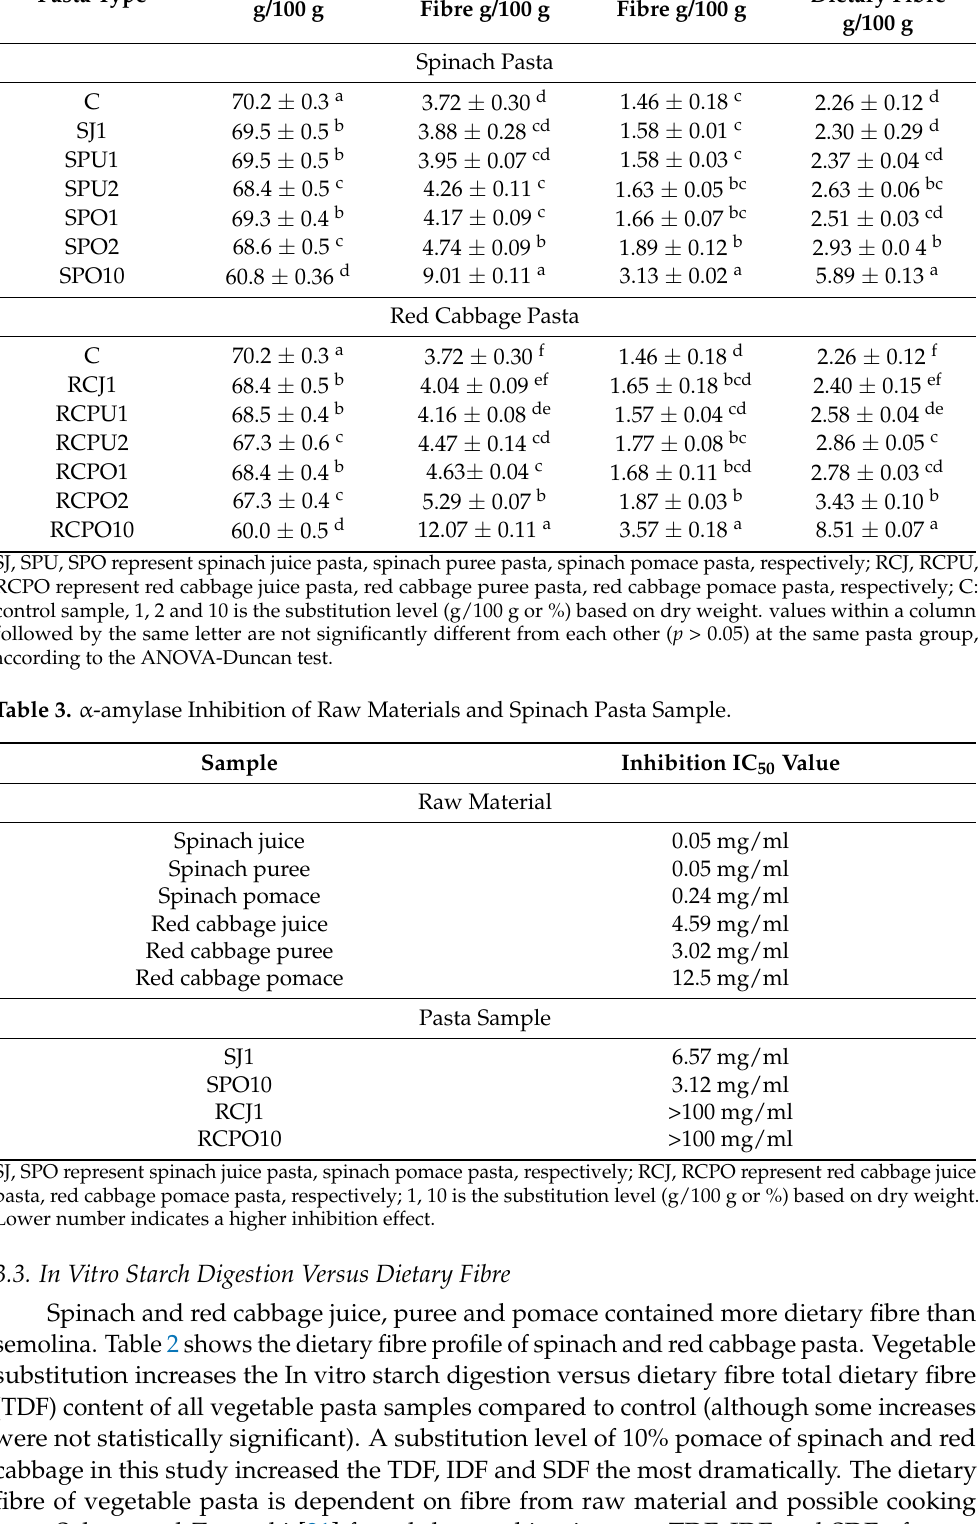
Total Starch g/100 g